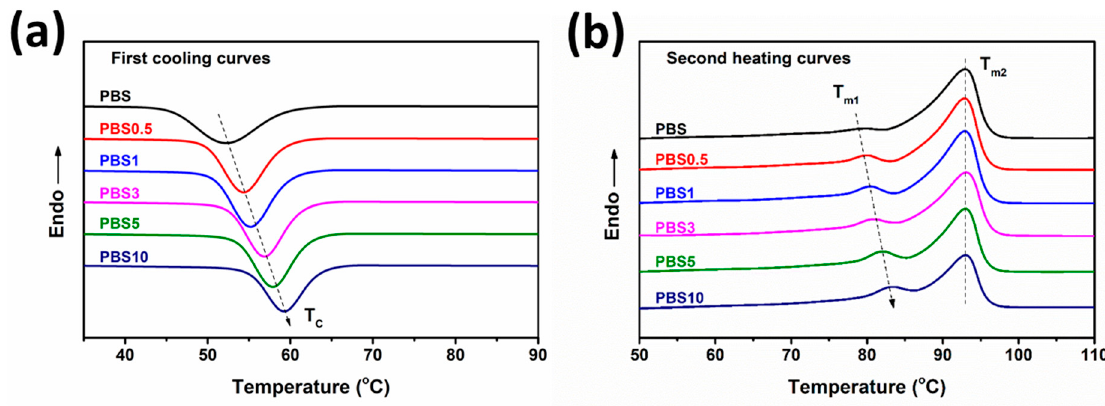
Figure 3. DSC curves of neat PBS and PBS/CB nanocomposites: ( a ) first cooling curve; ( b ) second heating curve.